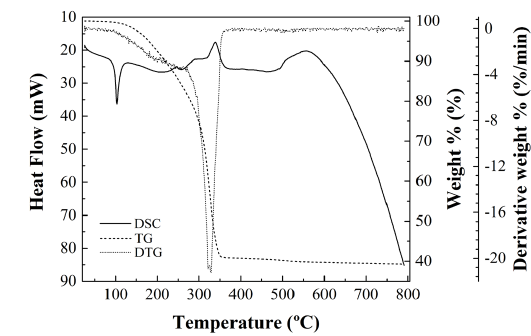
Fig. 3. TG/DTG and DSC curves for [UO